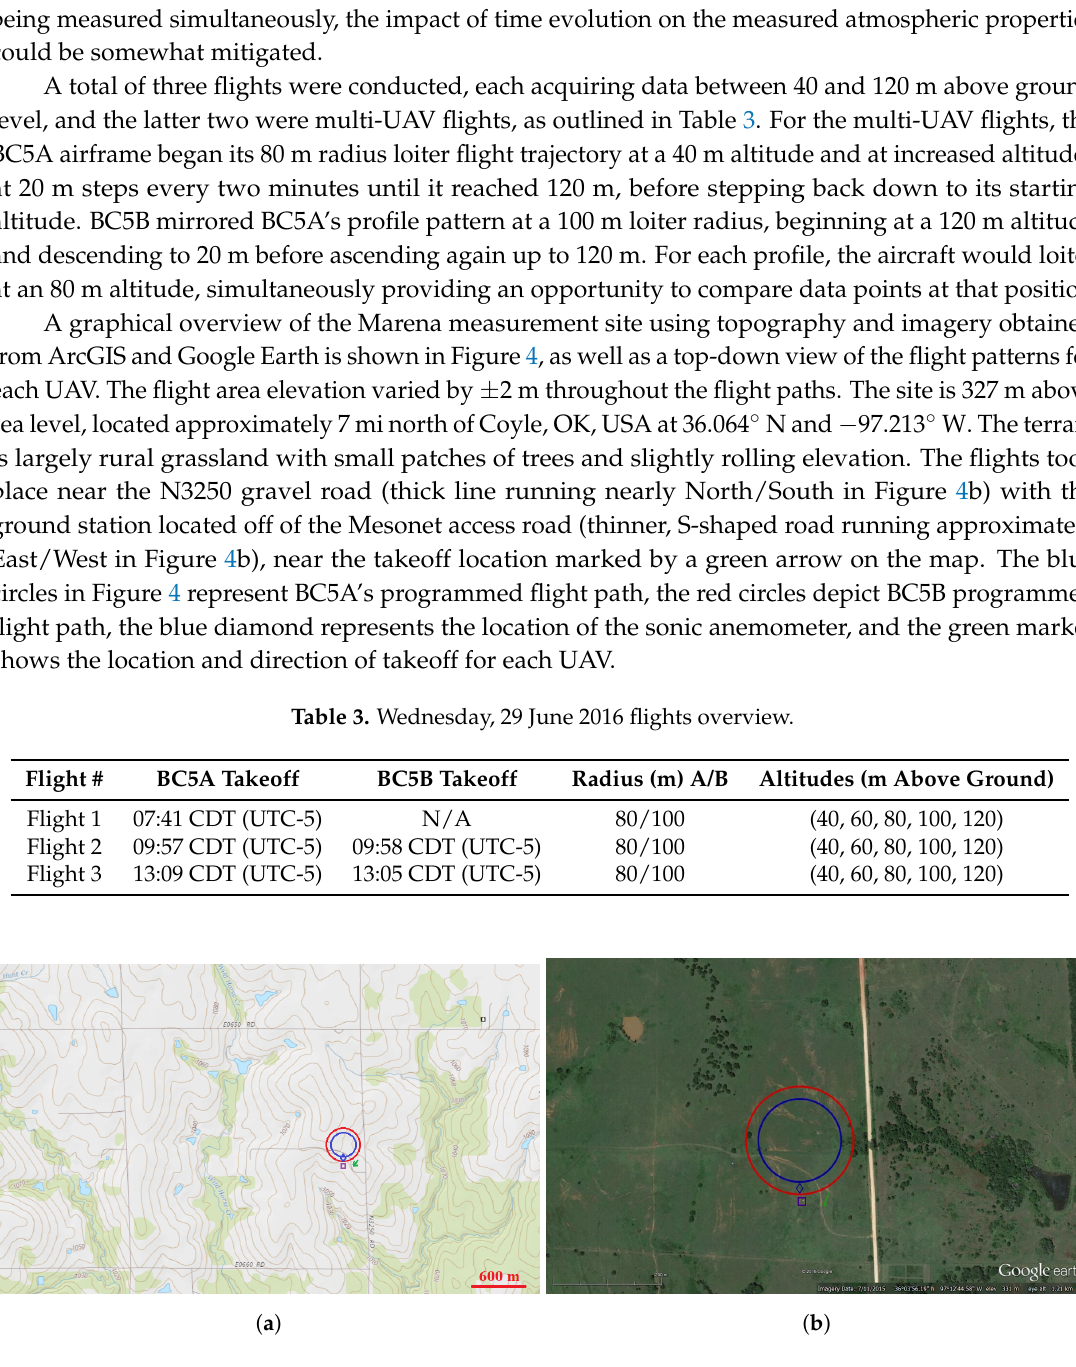
Figure 4. Graphical overview of Marena Mesonet location showing flight paths of BC5A and BC5B. The green arrow indicates takeoff location, the diamond indicates sonic anemometer location and the square indicates Mesonet station location. Locations and sizes on map are approximate. ( a ) Topographic map of region surrounding Marena Mesonet site. Data from ArcGIS. ( b ) Aerial image of terrain in close proximity to Marena Mesonet site. Data from Google